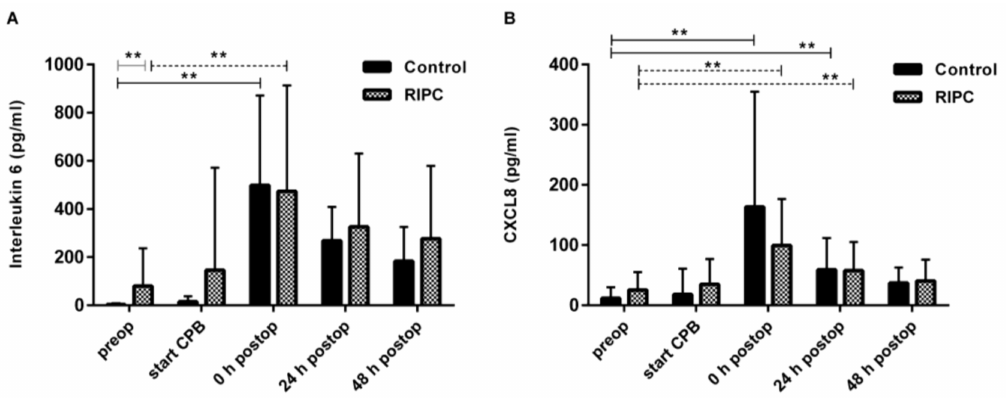
Figure 3. Secretion profile of proinflammatory cytokine IL-6 and CXCL8 in the control and RIPC serum. Pre-, peri-, and postoperative concentrations of ( A ) IL-6 and ( B ) CXCL8 in serum samples assessed by ELISA. Data represents means ± SD; ** p